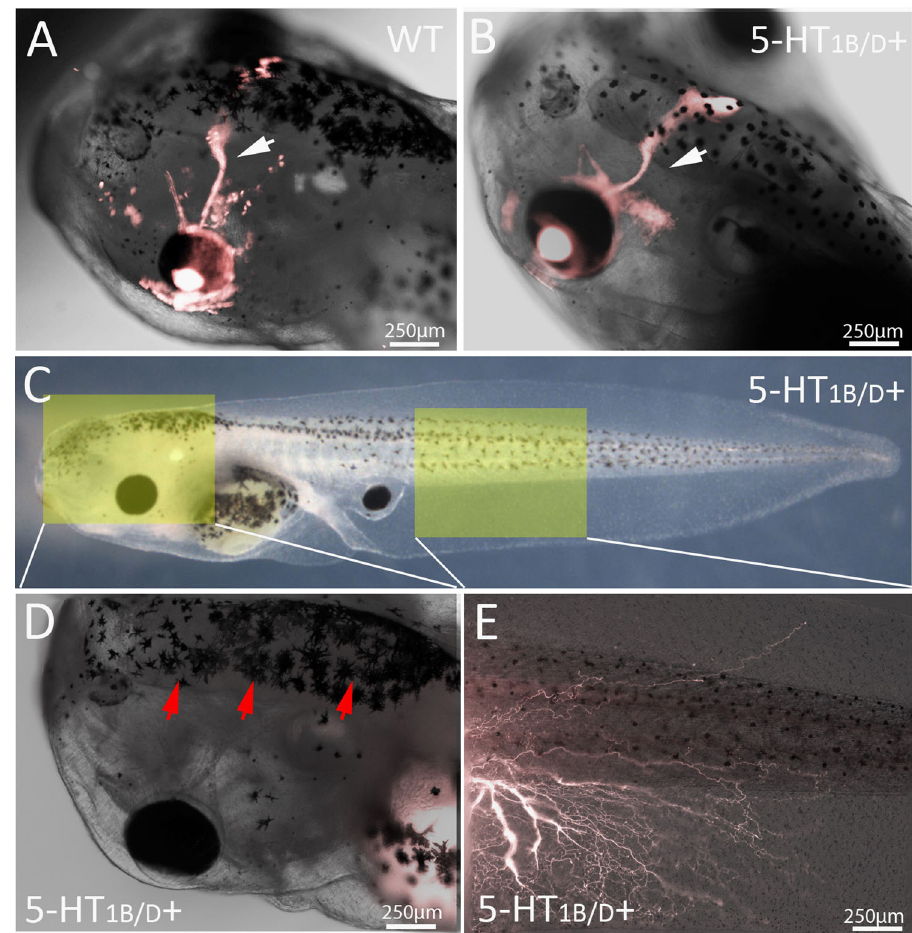
Fig. 2 5-HT 1B/D -induced innervation is location-speci fi c. a When developing eye tissue is removed in stage 24 embryos and replaced with labeled donor tissue of the same type, optic nerves are visualized ( white arrow ) crossing to the contralateral side of the brain and penetrating at the optic tecta. b Grafts at correct developmental locations do not change their innervation in response to 5-HT 1B/D activation. c Animals with posterior grafts were visualized under fl uorescence to determine if neurites reached the host brain. d Signal was never observed in the host brain ( red arrows ), e even when innervation was observed throughout the trunk and fi n region of the animal ( n = 20). Yellow boxes in ( c ) indicate location imaged at high magni fi cation in ( d ) and ( e